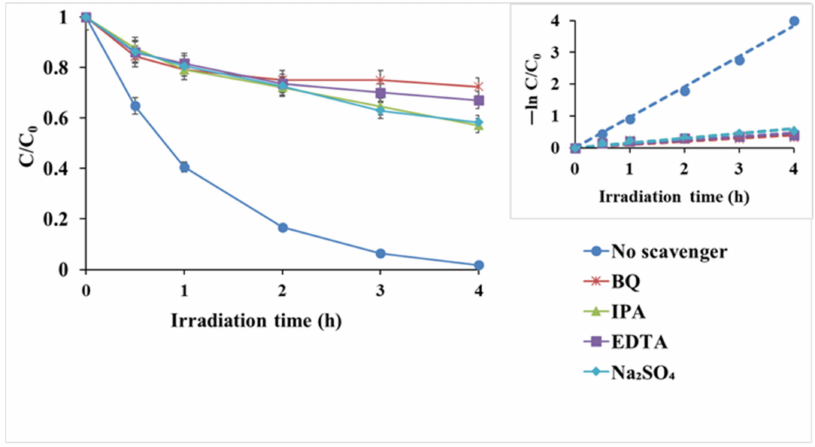
Figure 11. Effect of 1 mM concentration each of chemical scavengers on caffeine degradation (1 g/L Ag-ZnSnO 3 , [CAF] 0 = 10 mg/L, and initial pH = 7.5) and its corresponding apparent degradation rate constant